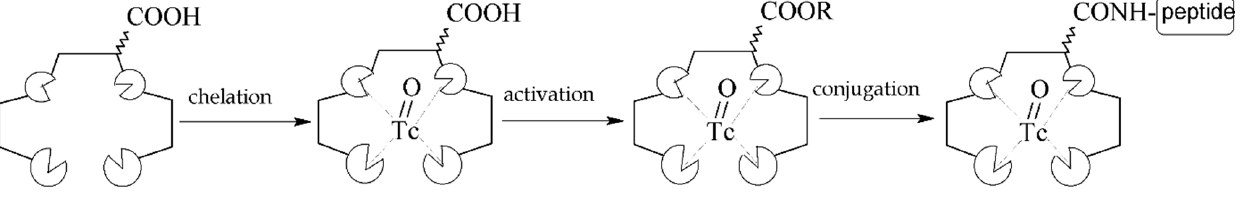
Figure 5. Scheme of the pre-labeling procedure with technetium-99m (adapted according to [3]). The post-labeling procedure (Figure 6) is the most widely used for a synthesis of target-specific peptide radiopharmaceuticals.